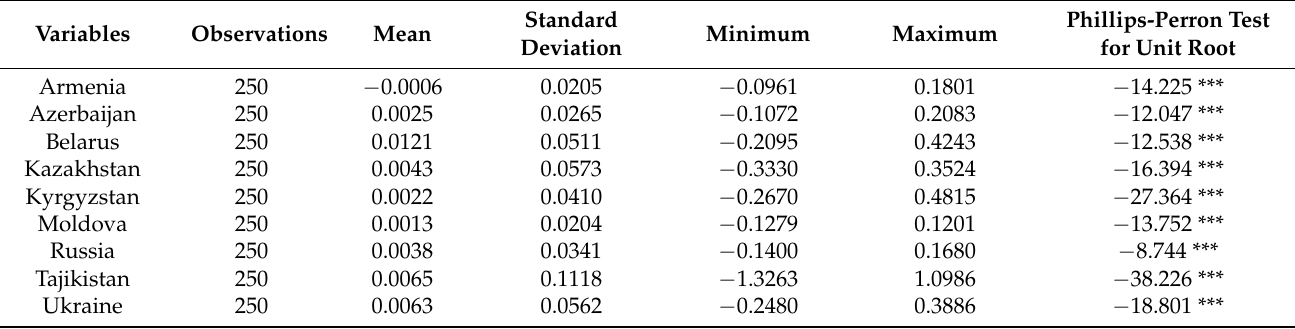
Table 6. Logarithmic Difference of Monthly Exchange